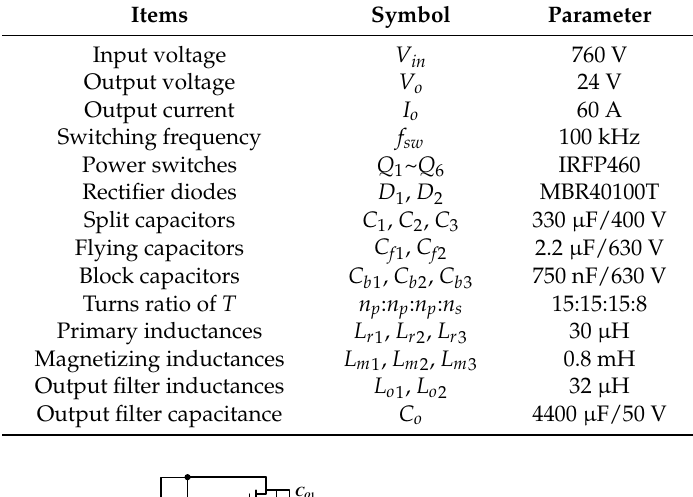
Table 1. Prototype Specifications.